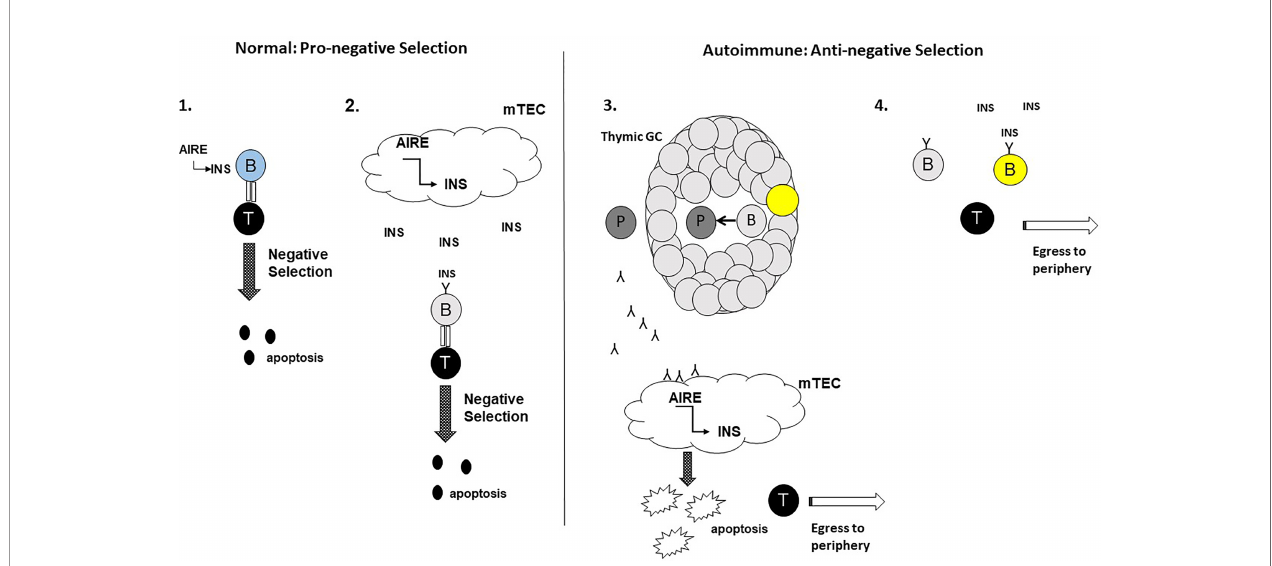
FIGURE 1 | Potential roles for thymic B cells in the thymic negative selection process: a hypothesis. In the normal setting, thymic B cells enhance the negative selection of autoreactive T cells. 1. Aire + Thymic B cells (blue) express and present self-antigens e.g. insulin (INS) to autoreactive T cells with high af fi nity TcRs for the self-antigens leading to T cell apoptosis. 2. Self-antigens e.g. INS secreted by Aire + mTECs are acquired by thymic B cells expressing self-reactive BcRs (light grey). Internalisation, processing and presentation of the self-antigen to autoreactive T cells leads to T cell apoptosis. In the autoimmune setting, thymic B cells impede the negative selection of autoreactive T cells. 3. The emergence of thymic GCs results in thymic B cells receiving signals to develop into plasma cells (dark grey) secreting autoantibodies for self-antigens expressed by mTECs. Binding of the autoantibodies to mTECs leads to mTEC apoptosis, leading to decreased negative selection of autoreactive T cells and increased egress of the T cells to the peripheral tissues. 4. Somatic hypermutated (yellow) thymic B cells egressing from thymic GCs, may outcompete ‘ normal ’ thymic B cells for the binding of self-antigen in the thymic milieu impeding negative selection. For this scenario, the sm thymic B cells would either fail to adequately present the self-antigens to autoreactive T cells to support negative